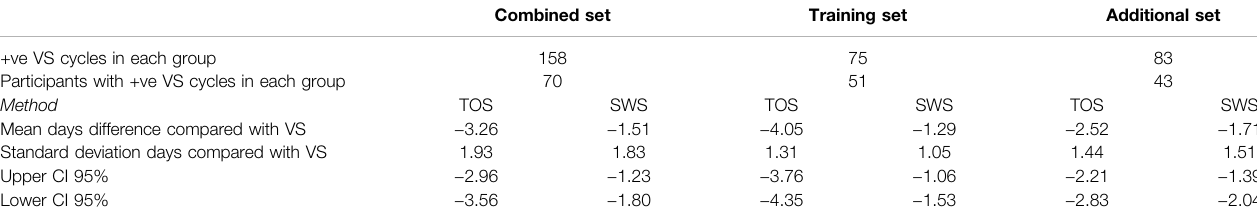
TABLE 4 | Days difference between TOS and SWS con fi rmed day of ovulation for ovulatory cycles compared with VS positive cycles for data sets.